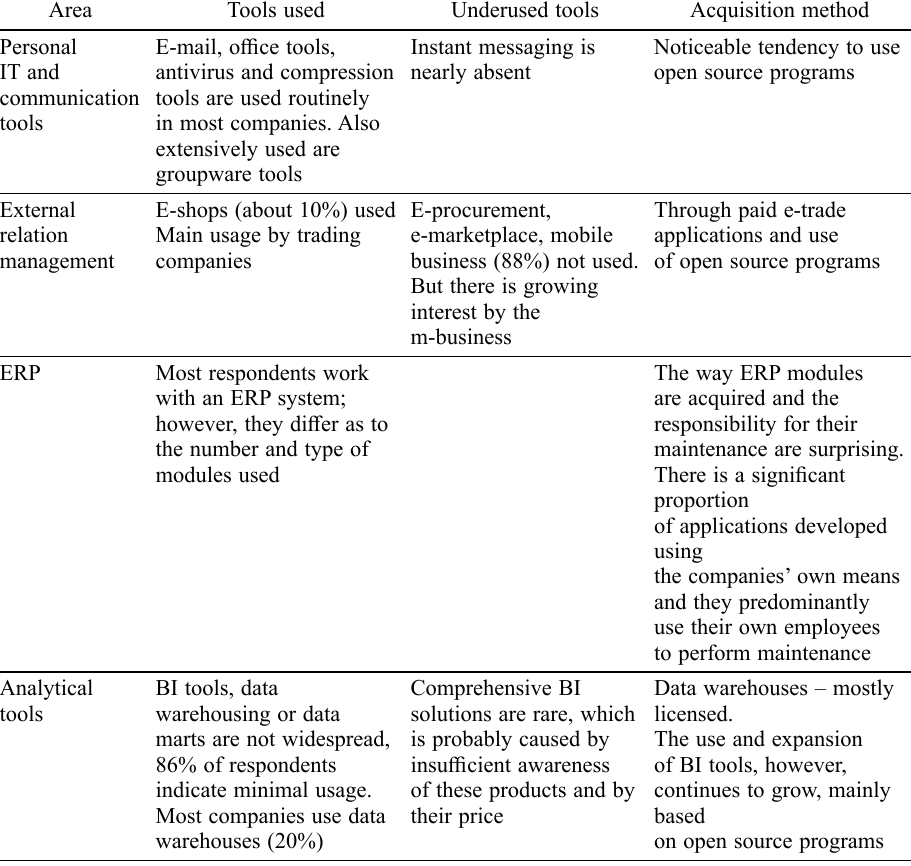
Table 4. IT use to support SME activities in the Moravian-Silesian region – survey results Area Tools used Underused